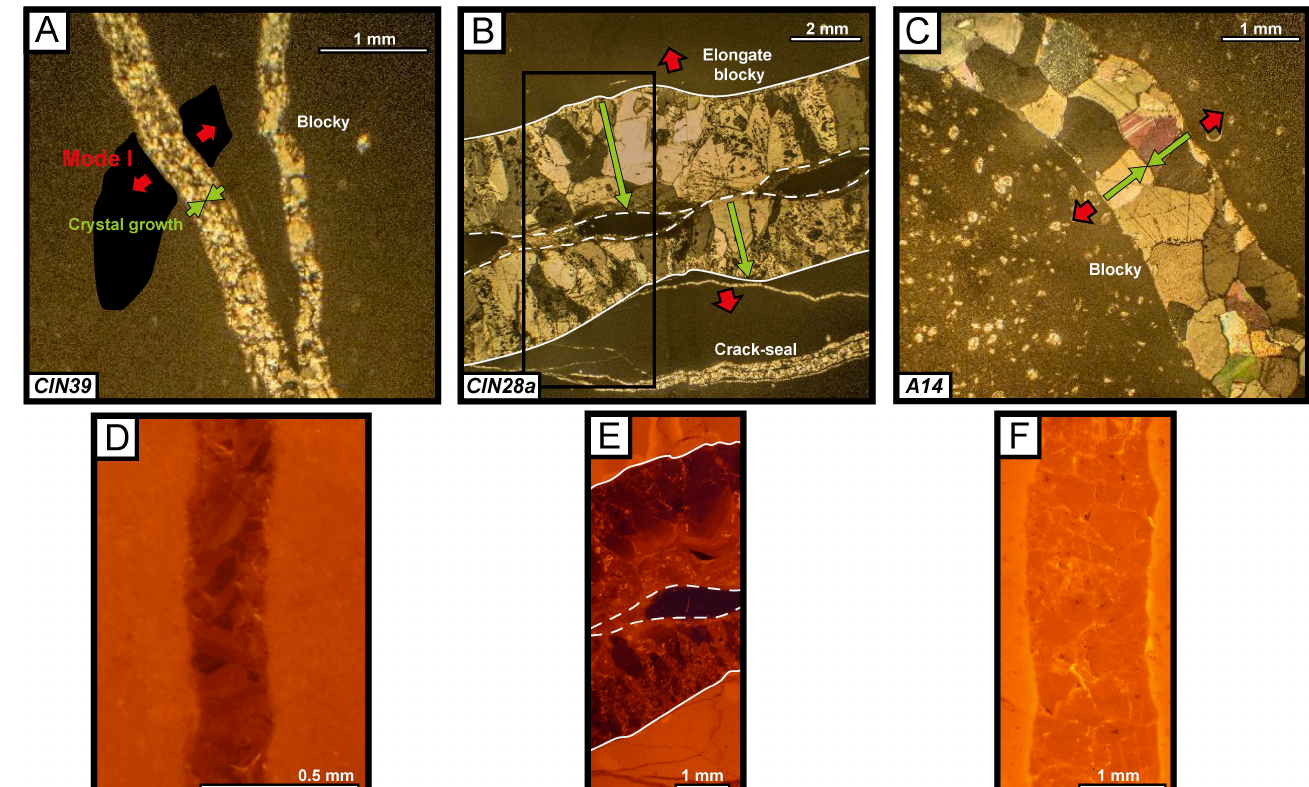
Figure 2. Observation of the different types of fractures in optical microscopy. ( A ) N-S fractures, ( B ) N045 fractures and ( C ) N135-160 fractures. Textures and shifts in the matrix were characterized, in order to verify the deformation mode, based on the classification of [130]. Red arrows represent the direction of the opening (mode I), and green arrows the direction of calcite crystal growth. ( D – F ) observation of these different sets in cathodoluminescence, indicating a single crystallization phase, synchronous with the mode I